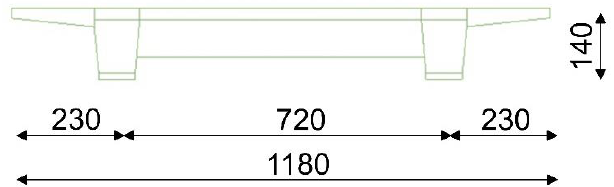
Figure 4. The geometry and main dimensions of the deck cross-section of the bridge [cm].